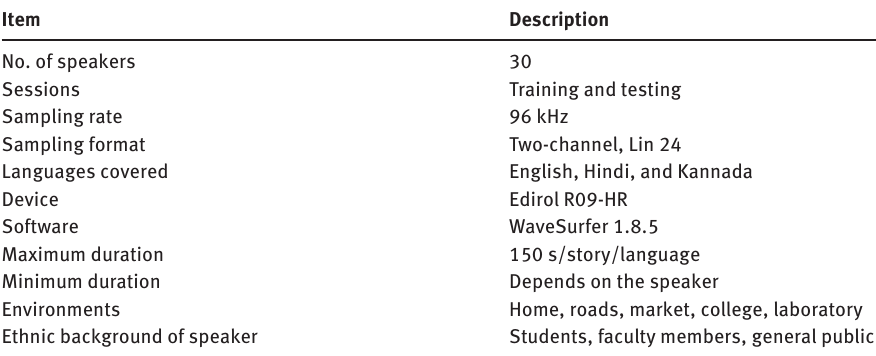
Table 1. Description of the Speech